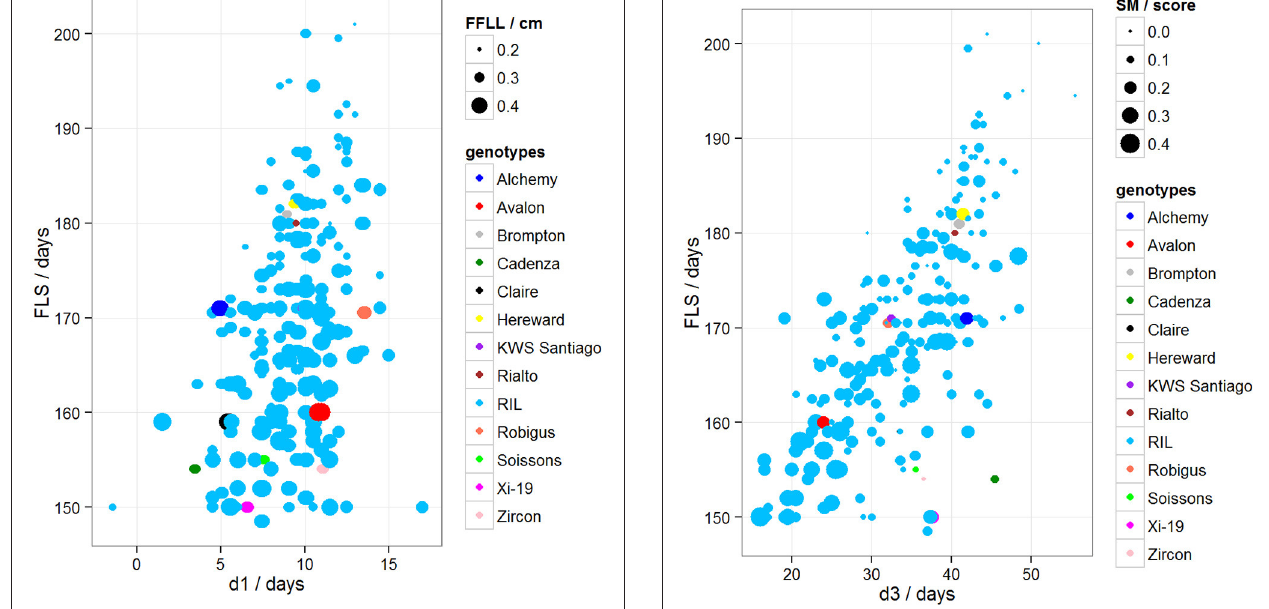
FIGURE 5 | Variation between d3 and FLS, where d3 = days between GS55 and FLS. Dot size represents disease score/10. Blues dots correspond to RILs and other colored dots to MAGIC